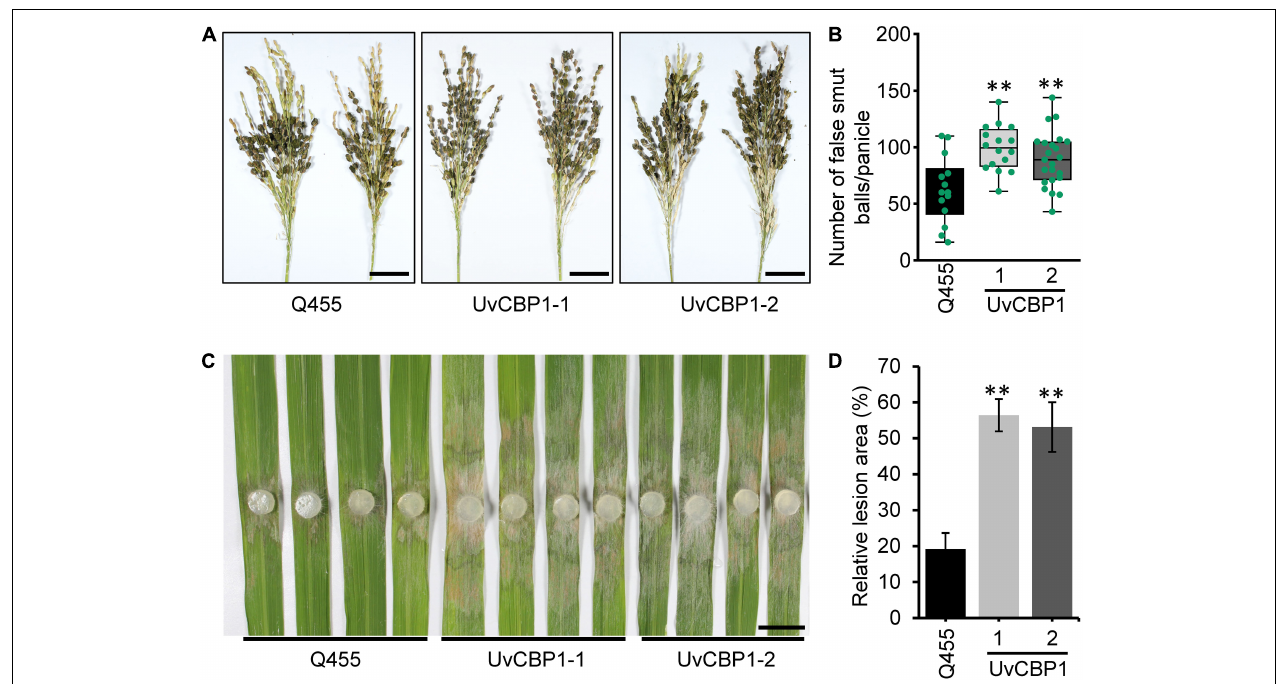
FIGURE 7 | UvCBP1 enhances pathogen infection in rice. (A,B) Rice false smut disease assay. U. virens PJ52 was inoculated into rice panicles at late booting stage. Disease phenotype was recorded at 24 days post inoculation (dpi) (A) , and the number of false smut balls per panicle was box plotted (B) . Scale bar, 4 cm. (C,D) Rice sheath blight disease assay. Rice leaves were inoculated with mycelial plugs of Rhizoctonia solani strain AG1-IA. Disease phenotype was recorded at 2 dpi (C) , and the relative lesion area was calculated (D) . Scale bar, 2 cm. Asterisk in this figure indicates significant difference determined by Student’s t test (** P <